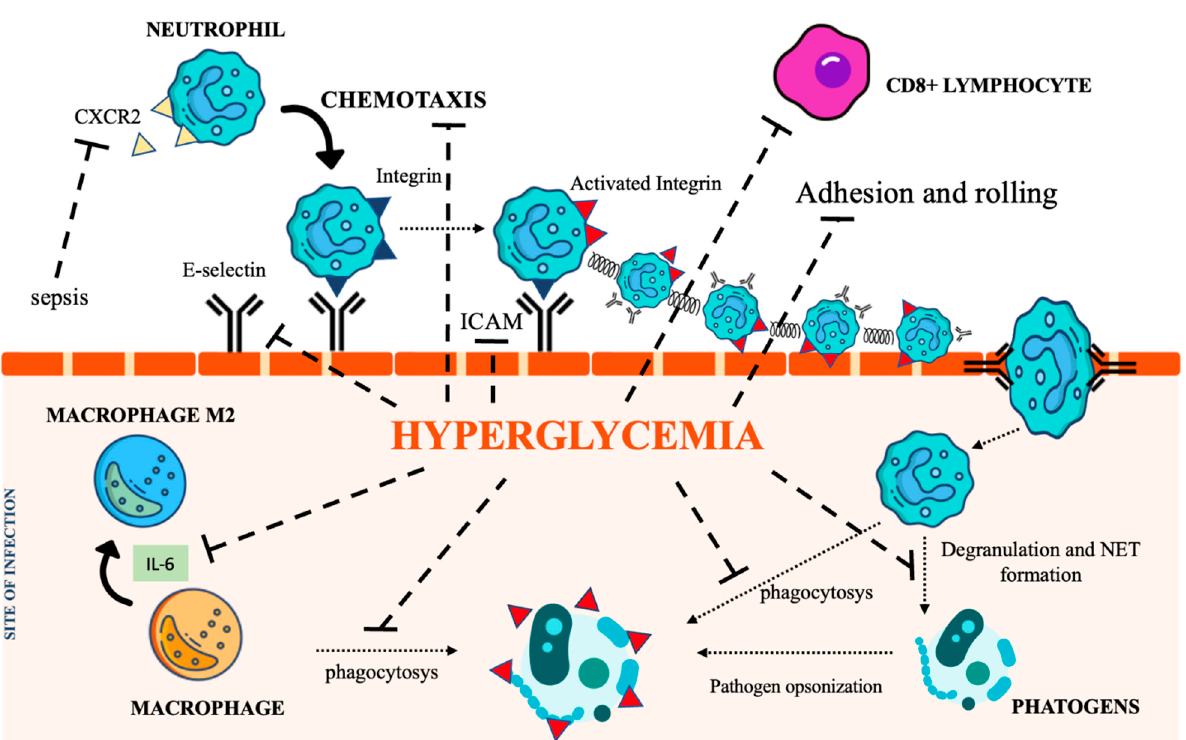
Figure 2. The immunological pathways under the control of hyperglycemia. CXCR2 (C-X-C Motif Chemokine Receptor 2), IL-6 (interleukin 6), NET (Neutrophil extracellular traps), ICAM (intercellular adhesion molecules). Icon design by icons8.